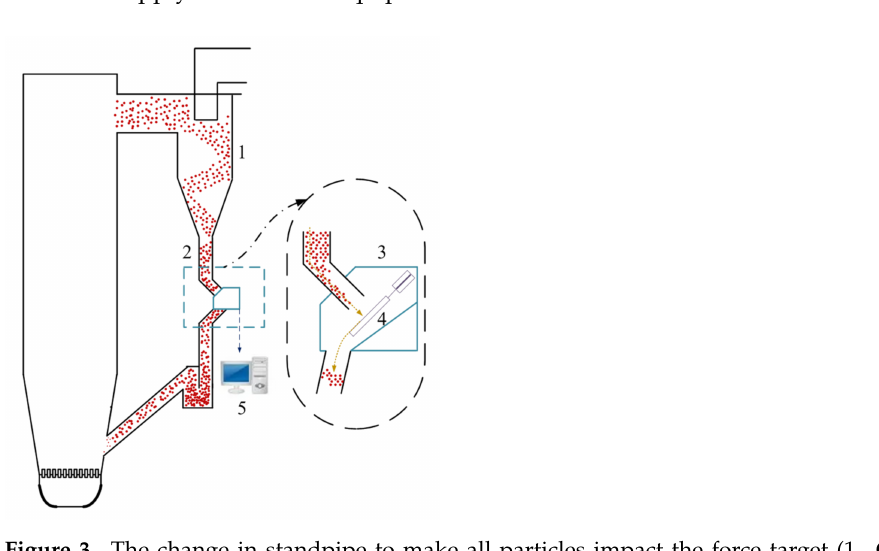
Figure 3. The change in standpipe to make all particles impact the force target (1. Cyclone; 2. Standpipe; 3. Measurement box; 4. Force target; 5. Signal capture and treatment